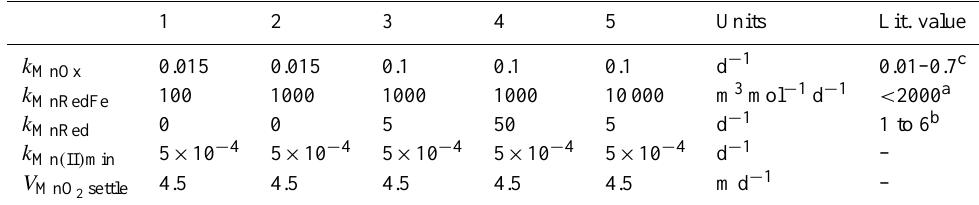
Fig. 9. Five modeled profiles of dissolved and particulate Mn using parameters specified in Table 6. Points represent field data, while the dashed lines are the model. Table 6. 1-D Model